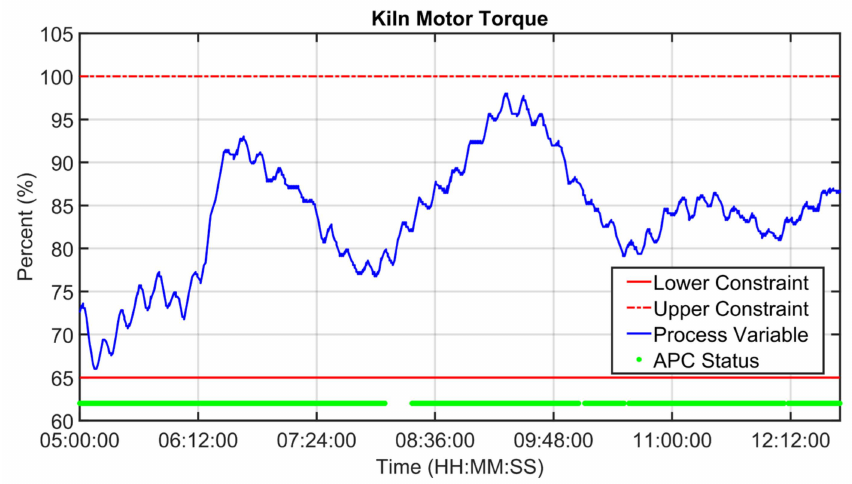
Figure 22. Rotary kiln APC system: field results (kiln motor torque